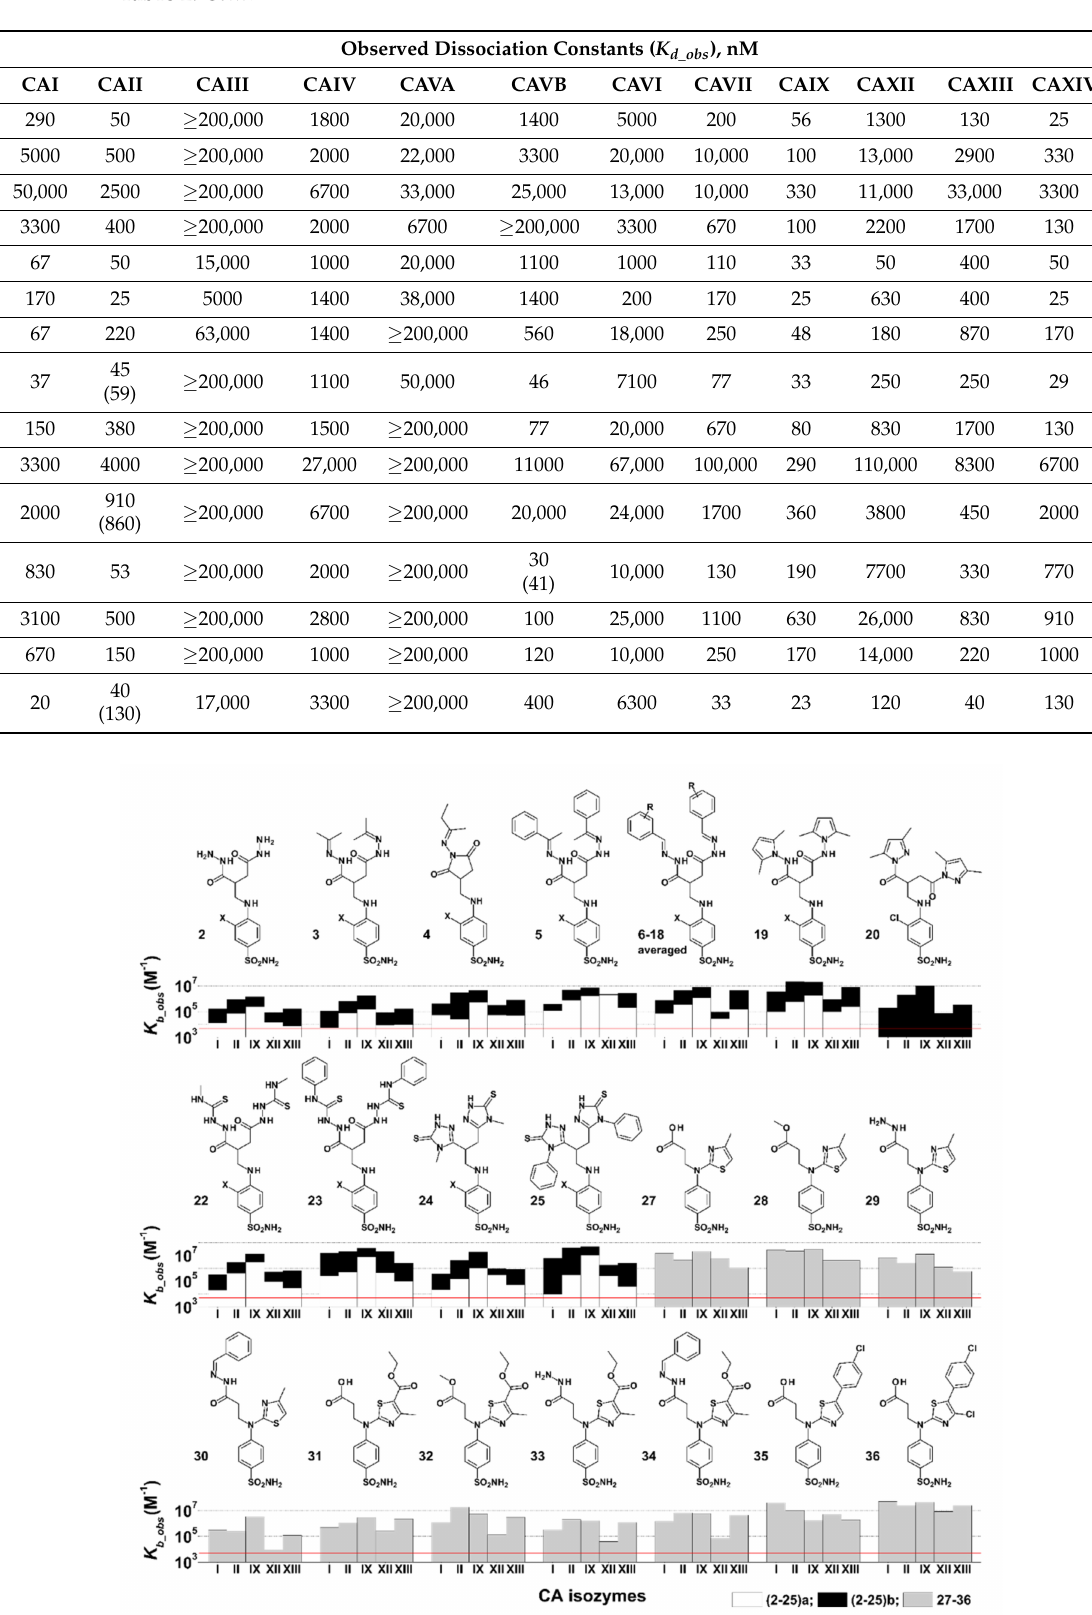
Figure 3. The observed binding constants ( K b_obs ) of compounds 2 ( a , b ) –19 ( a , b ), 20 , 22 ( a , b ) –25 ( a , b ), and 27 – 36 interaction with CAI, CAII, CAIX, CAXII, and CAXIII. Compound chemical structures